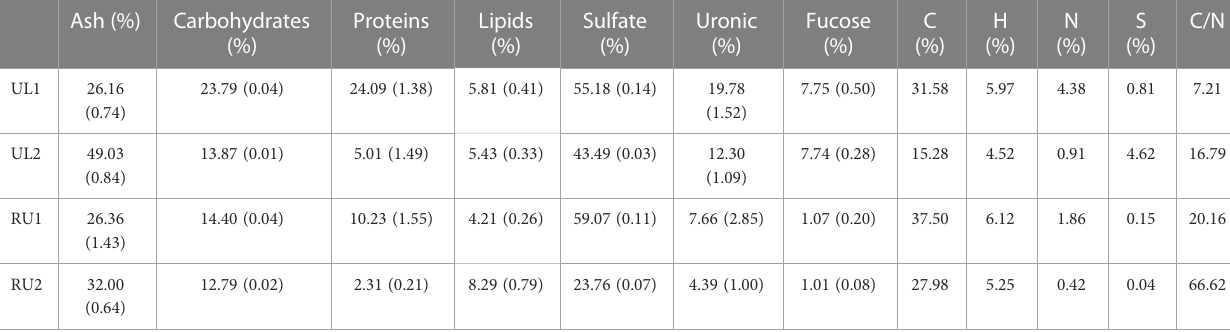
TABLE 2 Biochemical composition of Ulva ohnoi and Rugulopteryx okamurae